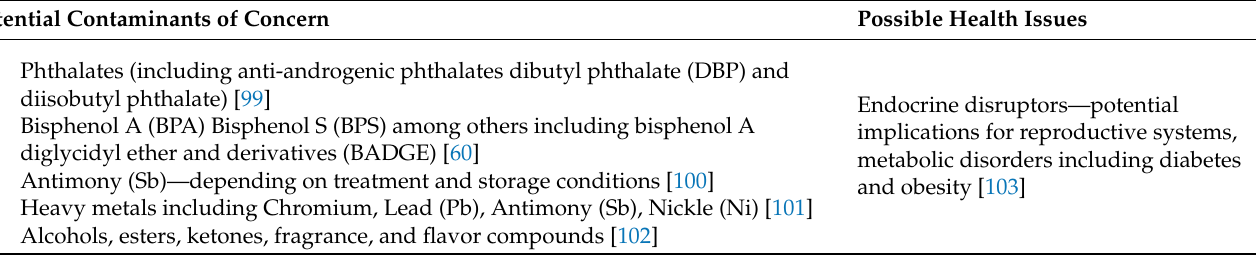
Table 5. Potential contaminants of concern and possible health issues related to use of recycled plastics in food packaging